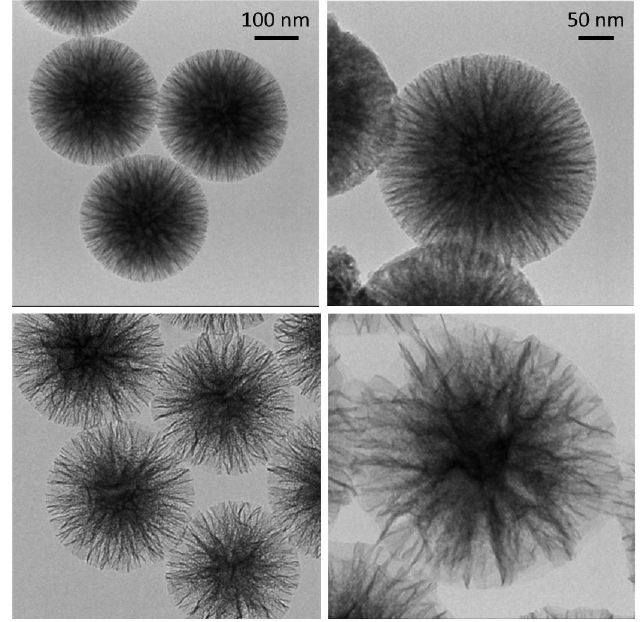
Figure 1. Transmission electron microscopy (TEM) micrographs of WSNs with isopropanol (WSN-ipa) (top) and WSNs with pentanol (WSN-p) (bottom) at lower (left) and higher (right) magnification.